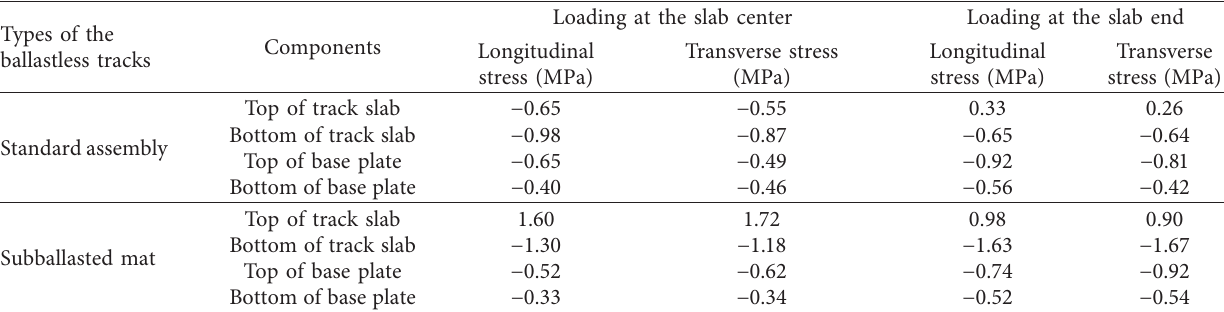
Figure 10: The static loading test: (a) static loading devices; (b) static loading procedure. Table 3: The maximum values of concrete stress.